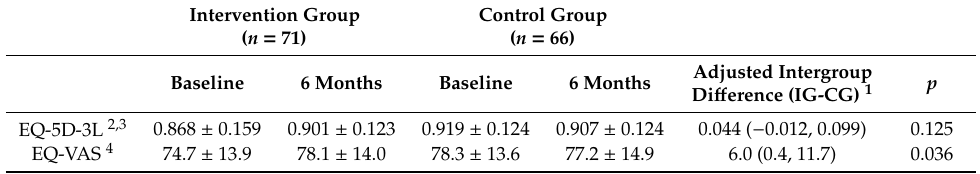
Table 3. Changes in the EQ-5D-3L score and EQ-VAS in postmenopausal women participants. Intervention Group ( n = 71)